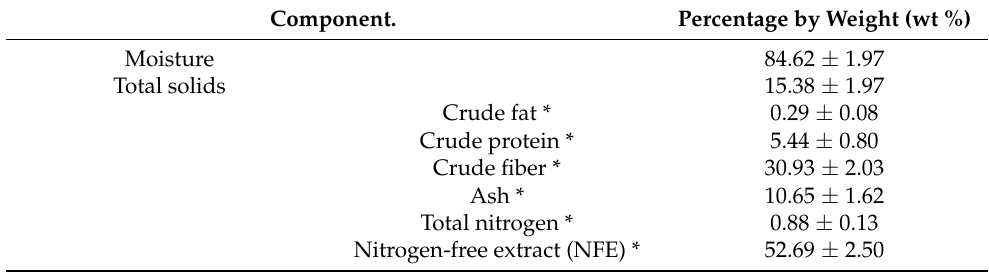
Table 1. Average proximate analysis of fresh cacao husk (CH) from clone CCN51 cacao fruit.